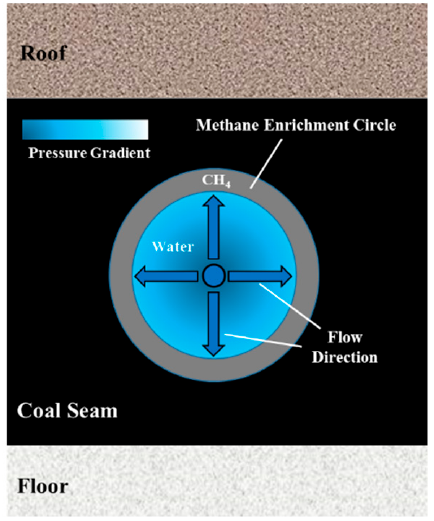
Figure 10. Schematic diagram of methane enrichment circle.